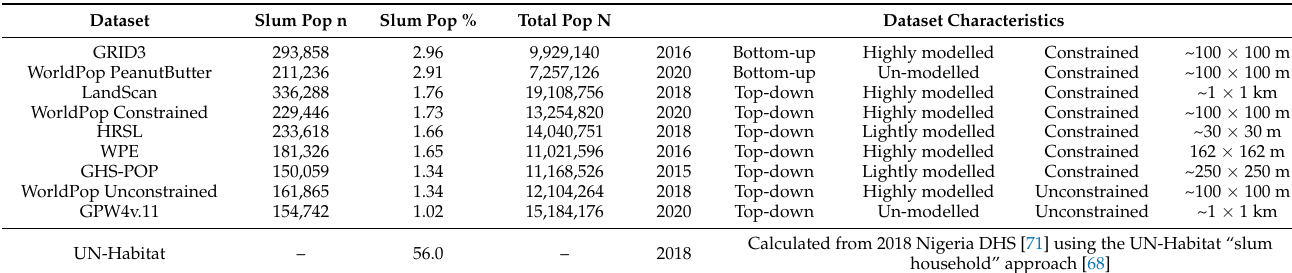
Table 3. Count and percent of the Lagos population living in slum settlements (SDG 11.1.1) as estimated by gridded population datasets, with estimates ordered from highest to lowest. UN-Habitat estimate of SDG 11.1.1 presented for comparison. Dataset Slum Pop n Dataset